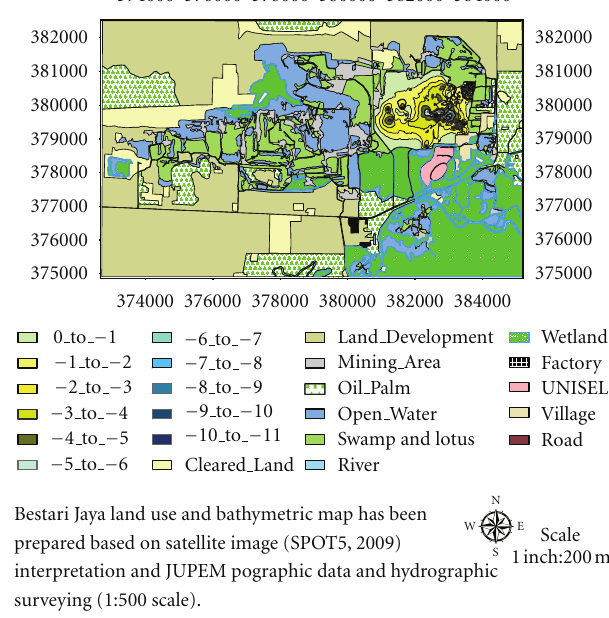
Figure 1: Land use map Bestari